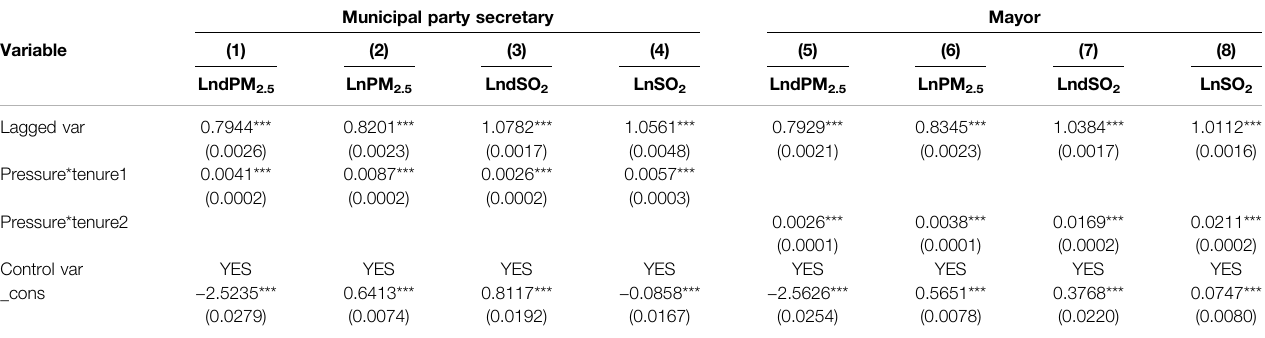
TABLE 7 | The role of of fi cial tenure in the environmental effects of fi scal